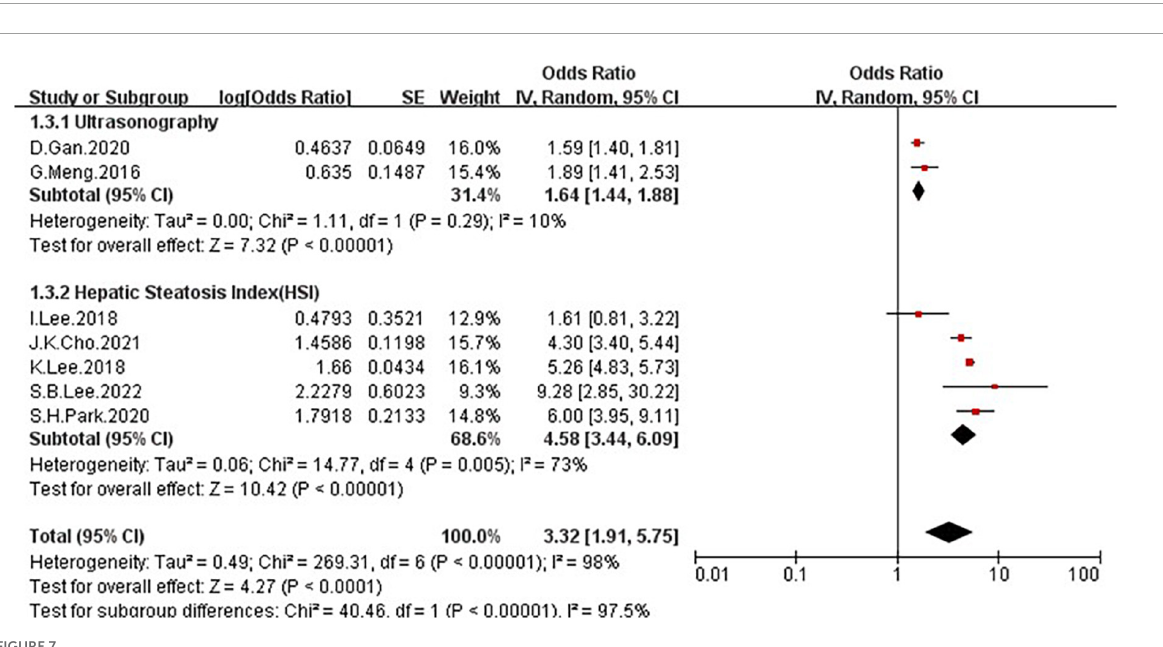
FIGURE6 Forest plots depicting the association of low grip strength and the risk of NAFLD were subgrouped by the method of grip strength ascertainment.